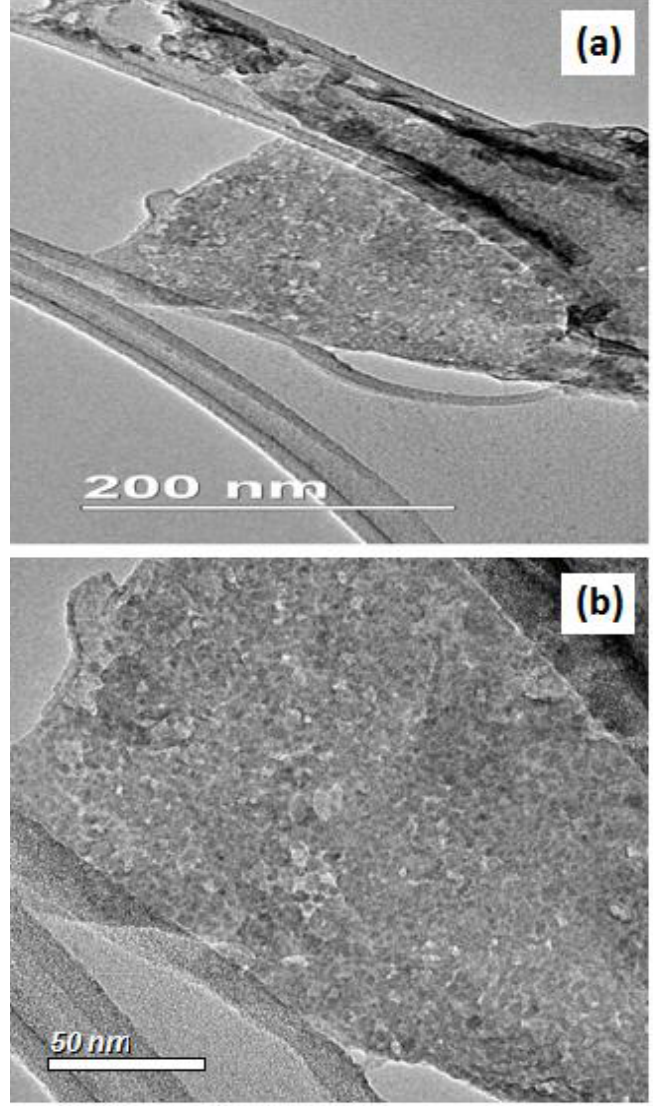
Figure 2. TEM images of rGO-ZnS at ( a ) low and ( b ) high magnification. A quantitative analysis by EDX, along with elemental mapping, was performed for the rGO-ZnS and rGO-ZnS-Ag nanocomposites in order to have a look at the composition of the nanocomposite. As shown in Figure 3a, the prepared nanocomposites are composed of C, O, Zn, S, and Ag elements. Furthermore, as shown in Figure 3b, SEM-EDX elemental mapping confirmed that the elements are not confined in a limited space; rather, they are distributed throughout the rGO matrix [29]. The existence of C and O peaks in the EDX spectrum also reinforced the graphene presence in the nanocomposites. No extra signal is present in the EDX spectrum, confirming the purity of the samples.